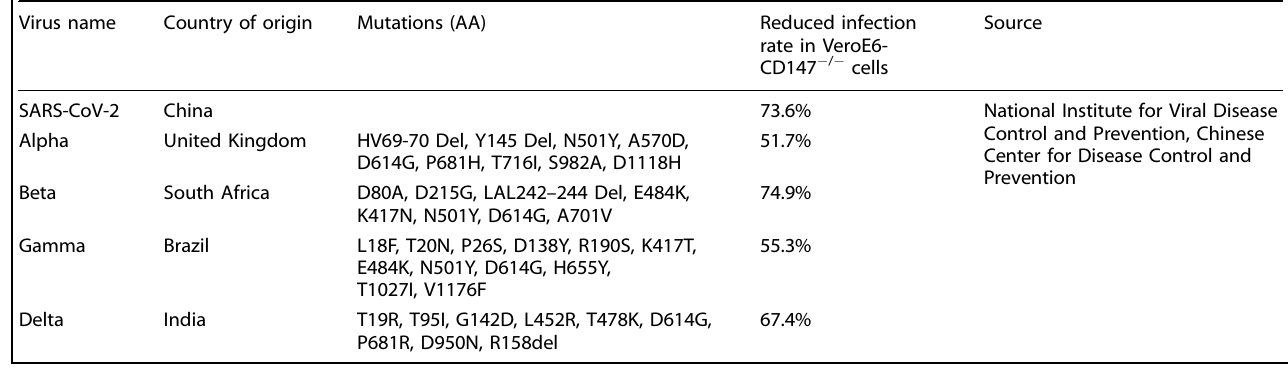
Table 1. SARS-CoV-2 variants features and the reduced infection rate in VeroE6-CD147 − / − cells